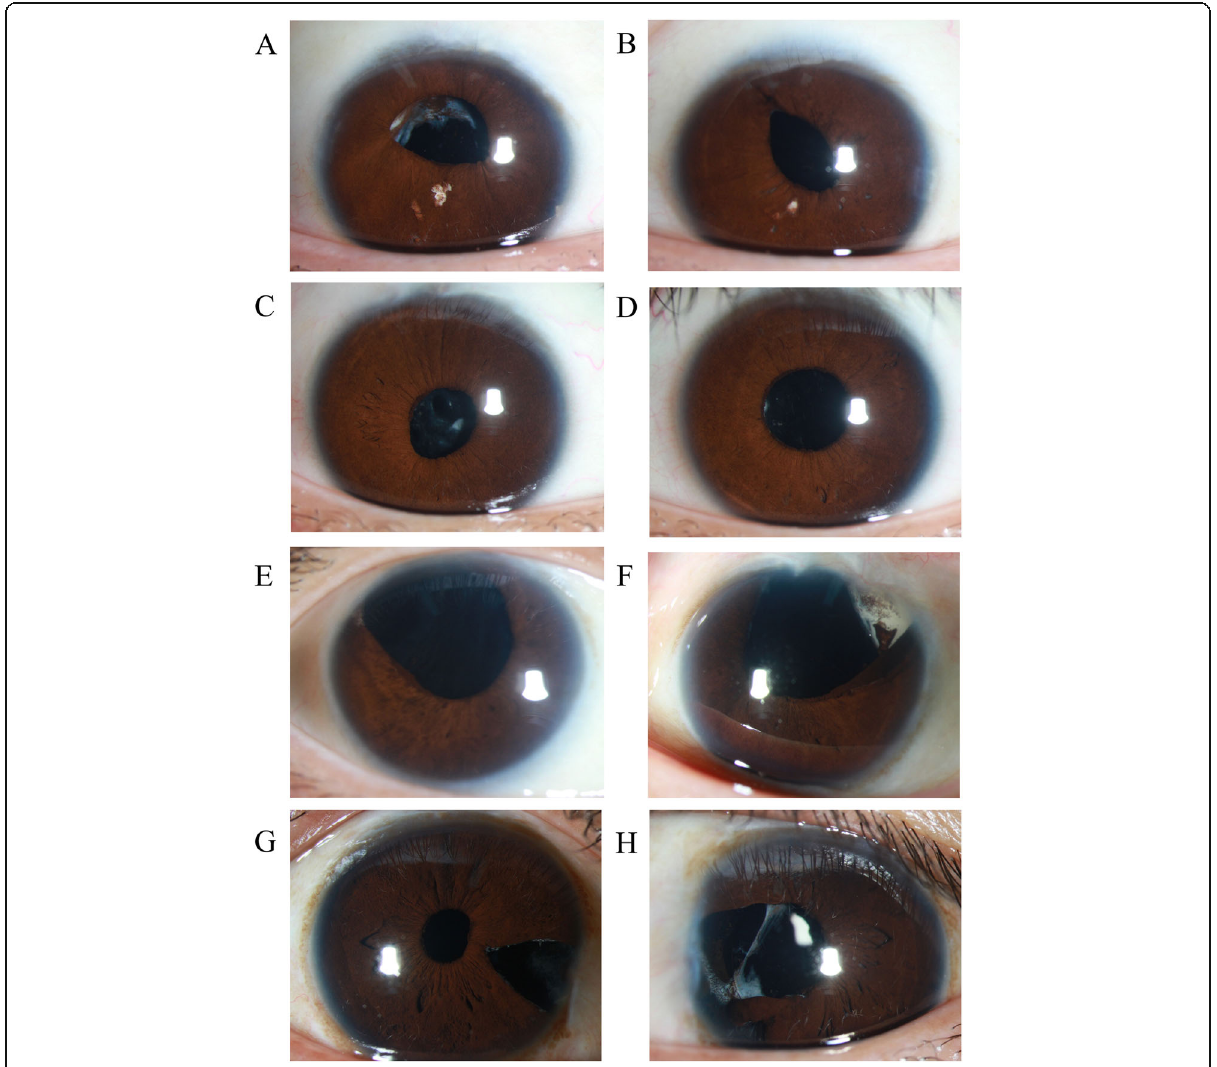
Fig. 1 Slit-lamp photograph of patients who had congenital cataracts. a : Right eye of the proband III:1. The pupil is upward. Thickened capsule can be seen. Intraocular lens is located in the right position. b : Left eye of the proband III:1. The pupil is not round. Intraocular lens is located in the right position. c : Right eye of patient III: 3. Pupil is not perfectly round. d : Left eye of patient III:3. Pupil is round. Intraocular lens is located in the right position. e : Right eye of patient II:1. Irregularly shaped pupil can be seen. Aphakia. f : Left eye of patient II:1. The iris has anterior adhesion from the 3 o ’ clock to 5 o ’ clock position. g : Right eye of patient II:3. There is a hole of circumferential iridectomy. Intraocular lens is located in the right position. h : Left eye of patient II:3. The pupil deformation is severe with capsule